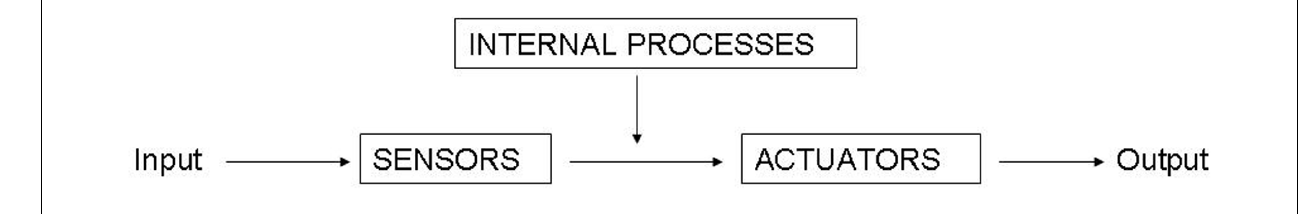
FIGURE 1 |The classical sensory input mapping into a motor